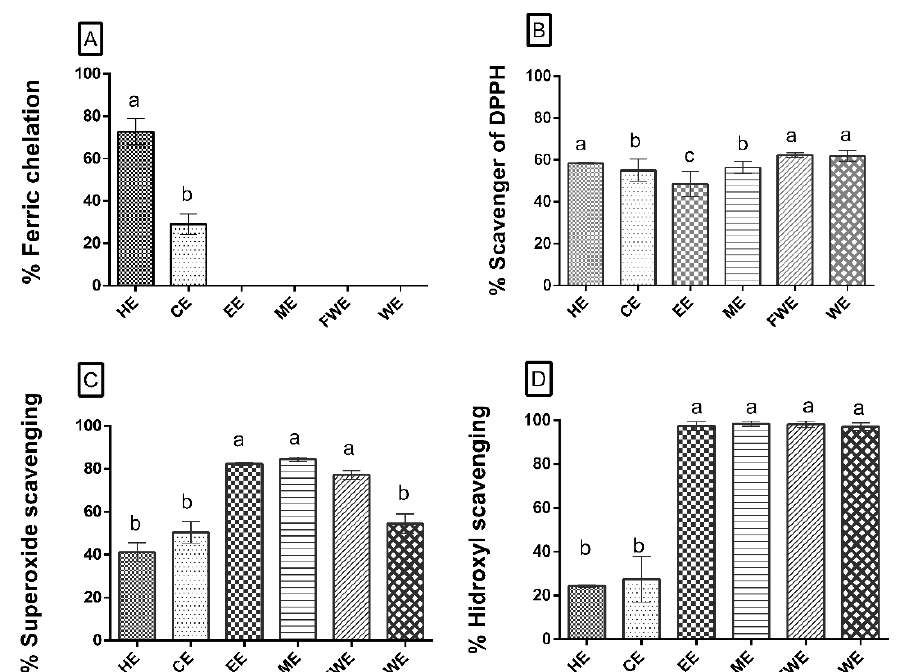
Figure 1. Antioxidant assay. ( A ) Percentage of ferric chelating effect of M. zehntneri extracts, where the y-axis corresponds to percentage of ferric ion chelation activity. ( B ) Percentage of DPPH radical- scavenging, where the y-axis corresponds to percentage of DPPH-scavenging activity. ( C ) Percentage of superoxide ion-scavenging, where the y-axis corresponds to percentage of superoxide ion- scavenging activity. ( D ) Percentage of the hydroxyl radical scavenging effect of the extracts at different concentrations, where the y-axis corresponds to percentage of hydroxyl radical-scavenging activity. In these tests, the x-axis corresponds to M. zehntneri extracts at a concentration 100 µg/mL for ( A ), ( C ), and ( D ) and at 25 µg/mL for ( B ). The assays were performed in triplicate. HE, hexane extract; CE, chloroform extract; EE, ethanol extract; ME, methanol extract; FWE, final water extract; WE, water extract. The data were analyzed by ANOVA–Tukey test p < 0.001. Different letters (a, b, c) correspond to the significant differences in statically analysis.